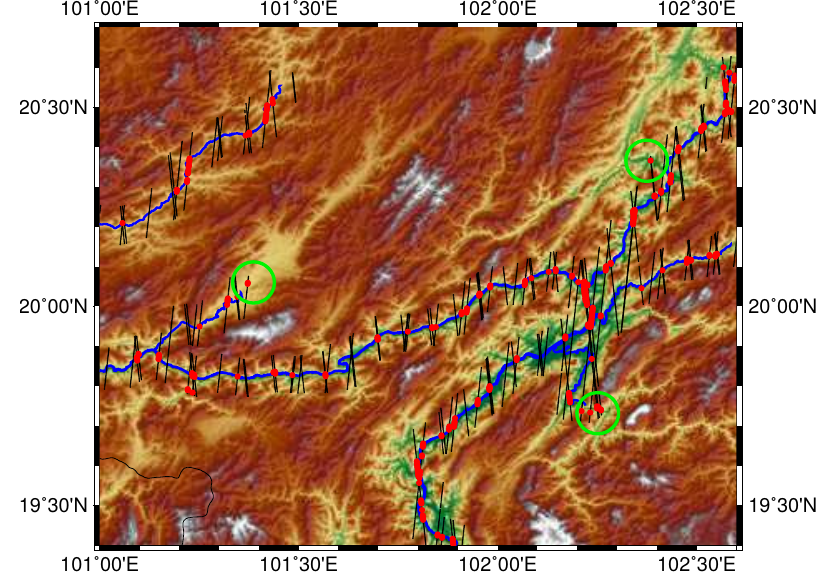
Figure 6. An example of the classification. The red dots are classified as water measurements, and black lines are the land-classified measurements. The three circles indicate areas where water was detected in river valleys which are not included in the river polygon. The background shows the HydroSHEDs topography